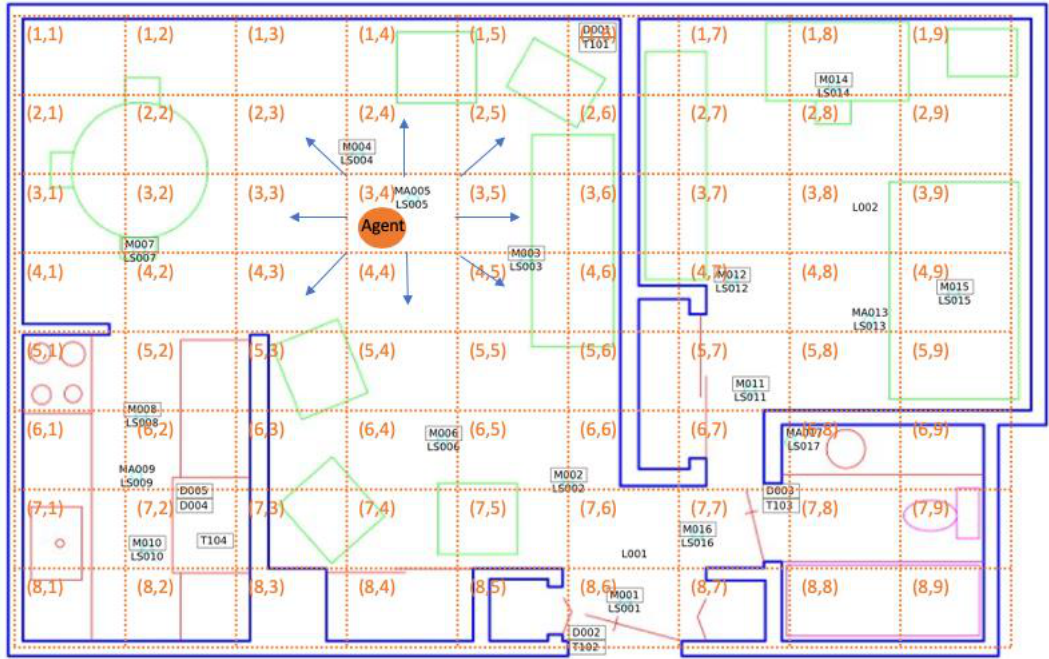
Figure 3. Markov Decision Process (MDP) representation of a smart home resident’s decision-making process in the context of a smart home floorplan.